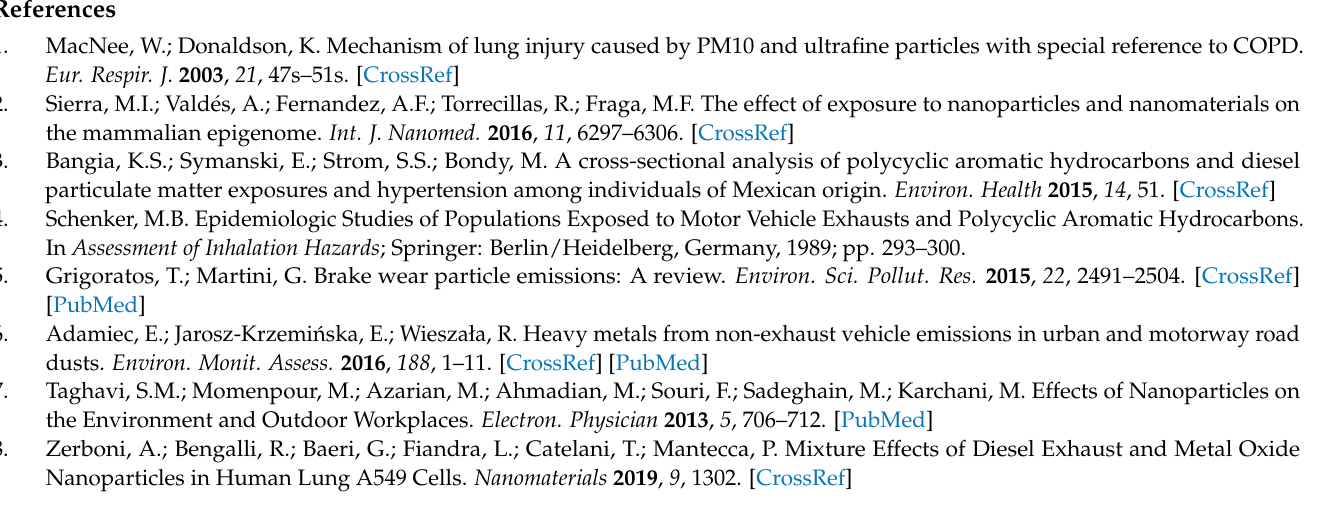
OES) analysis of metal dissolution from CuO and ZnO NPs and mixtures. Table S2: Dynamic light scattering (DLS) analyses of CuO and ZnO NPs and mixtures. Figure S1: Morphological characteriza- tion of particles using transmission electron microscopy (TEM): ZnO NPs (1.C); DEP + ZnO NPs (2.C); CuO (3.C); DEP + CuO (4.C). Figure S2: Colony type A. Colonies’ classification: E-cadherin (green), rhodamine phalloidin (red), and DAPI (blue) staining of colonies. Figure S3: Colony type B. Colonies’ classification: E-cadherin (green), rhodamine phalloidin (red), and DAPI (blue) staining of colonies. Figure S4: Colony type C. Colonies’ classification: E-cadherin (green), rhodamine phalloidin (red), and DAPI (blue) staining of colonies. Figure S5: Colony type D. Colonies’ classification: E-cadherin (green), rhodamine phalloidin (red), and DAPI (blue) staining of colonies. Figure S6: Percentage of viable, apoptotic, necrotic, and mitotic cells, according to Hoechst/PI staining, in control cells and cells exposed to ZnO; CuO (20 µ g/mL); DEPs (100 µ g/mL); and respective mixtures for 24 h. Statistical analysis was performed using one-way ANOVA with Dunnett’s multiple comparisons tests. *** p < 0.0001 vs. control. Figure S7: T mean area of colonies ( µ m 2 ) divided into the four types (A, B, C, and D) in control cells and cells exposed to ZnO; CuO (20 µ g/mL); DEPs (100 µ g/mL); and respective mixtures for 24 h. Figure S8: ( A ) ROS and ( B ) γ -H2AX fold increase in cells exposed to ZnO and CuO NPs (10 µ g/mL); DEPs (100 µ g/mL); and DEP + ZnO and DEP + CuO (concentration of NPs: 10 µ g/mL) mixtures for 24